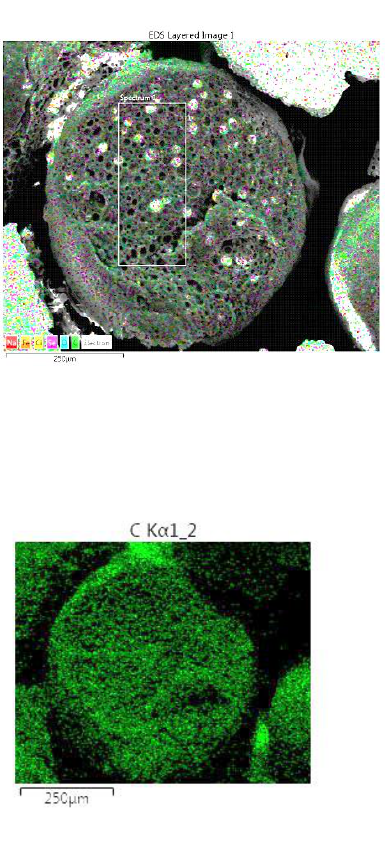
Table 3. The adsorption capacity of the A-LMS Fe 3 O 4 for Se removal from spiked drinking water. Sample